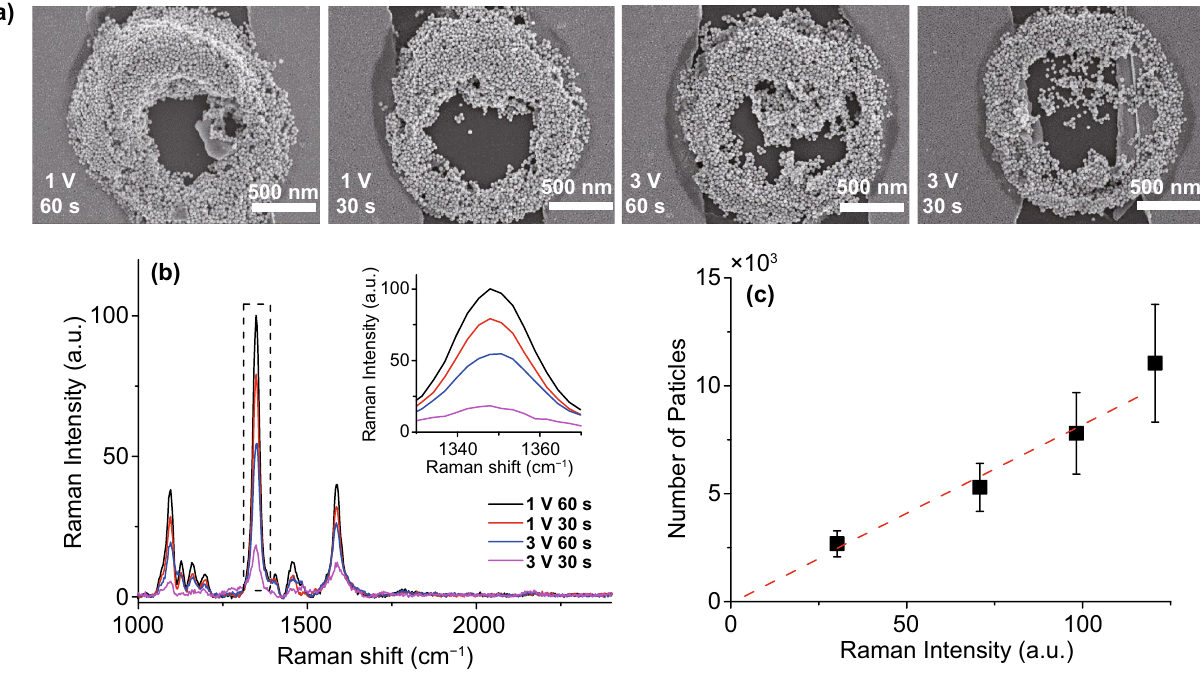
Fig. 4 SERS results of various PDEP Au nano-aggregates samples. a SEM images of Au nano-aggregates deposited by PDEP; 500 nm scale bar. b SERS spectra of various Au nano-aggregates coated with 4-nitrobenzenethiol; the inset graph is the expanded spectra in the dotted line (nitro group). c Raman intensity and particle count graph. The ratio of Raman intensity of peaks in the inset graph of b is linearly well-fitted (red dashed line) with the ratio of the number of Au nanoparticles, which indicates that Au nanoparticles enhanced Raman signal. Therefore, the sys- tem can be used for the fabrication of the nano-micro SERS platform by the enrichment of nanoparticles such as in the coffee-ring